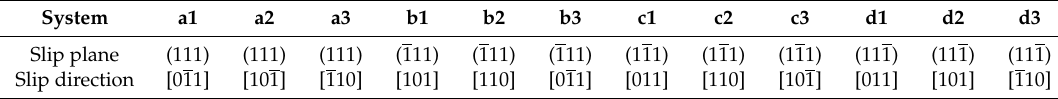
Table 2. Notations of slip systems for FCC crystals.